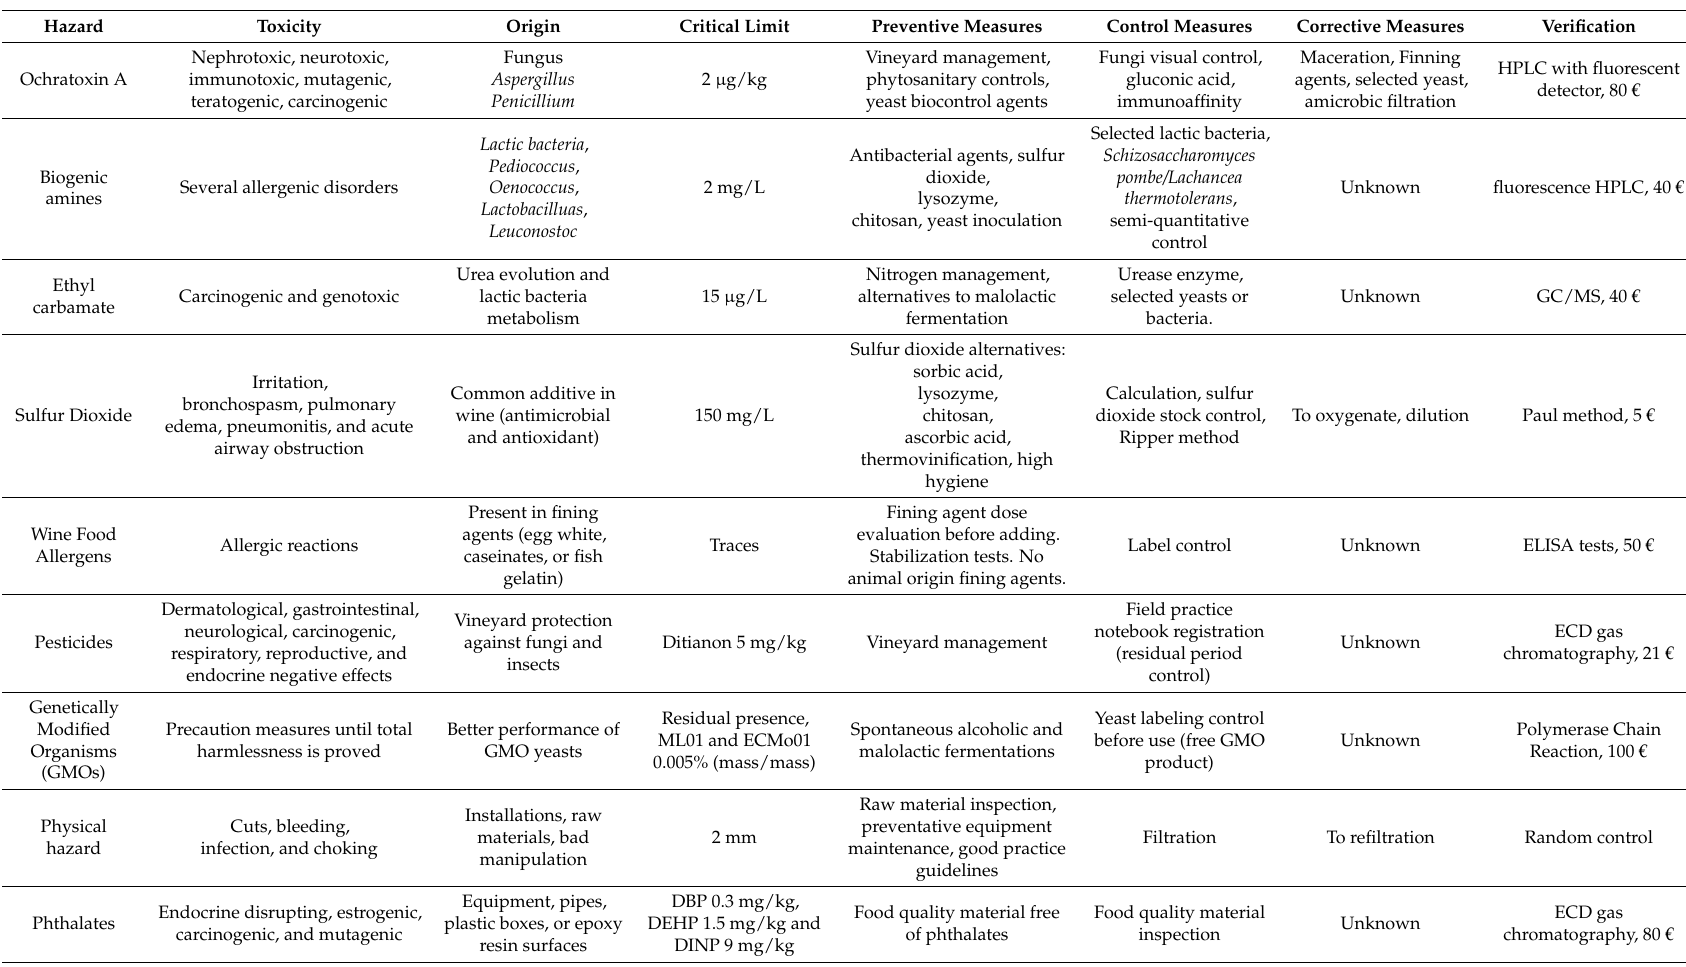
Table 1. The main wine-industry hazards and their management from a Hazard Analysis and Critical Control Point (HACCP) point of